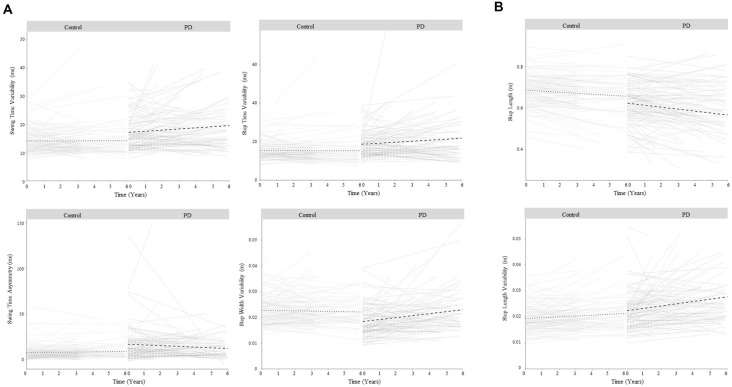
Change in gait over 6 years for control and Parkinson’s disease (PD) participants for gait characteristics that demonstrated a significant change in PD related to disease progression. Panel (A) shows gait characteristics that significantly changed in PD but not controls so demonstrated change related to disease progression only. Panel (B) shows gait characteristics that significantly changed in PD and control groups, but the rate of change was greater in PD, so demonstrated change related to both aging and disease progression. Bold lines show overall change within each group; faint lines show change for individuals.